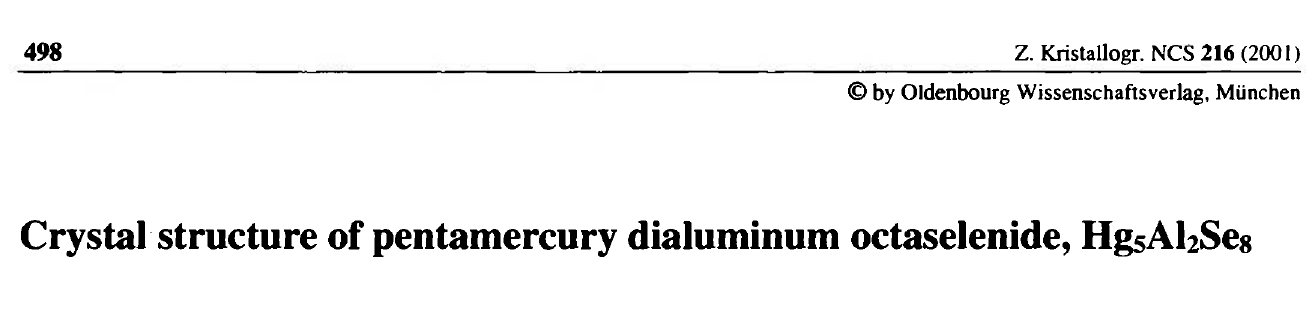
Table 2. Atomic coordinates and displacement parameters (in A 2